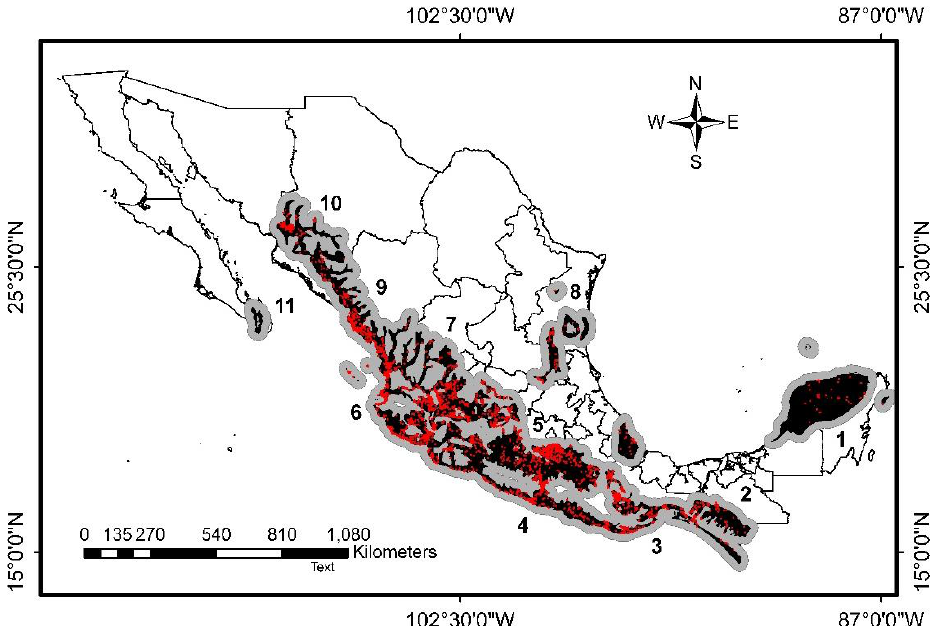
Figure 2. Locality records used for model performance (red dots). The black areas represent tropical dry forest [33], and the calibration area is shown in light gray. Numbers correspond to ecoregions included in the study region according to [13]: Yucatán forests (1), Chiapas forests (2), Centro American Pacific forests (3), Pacific South forests (4), Balsas River basin forests (5), Jalisco forest (6), Bajío forests (7), Tamaulipas-Veracruz forests (8), Sinaloa forests (9), Sonora forests (10), and Cape forests (11).